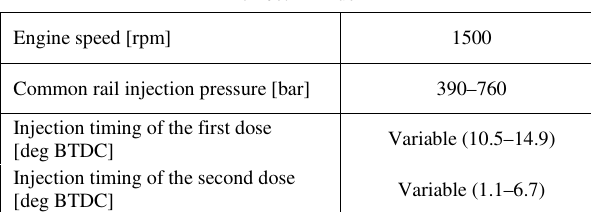
Table 3. Engine adjustment parameters for standard injection timing of Jet A-1 fuel